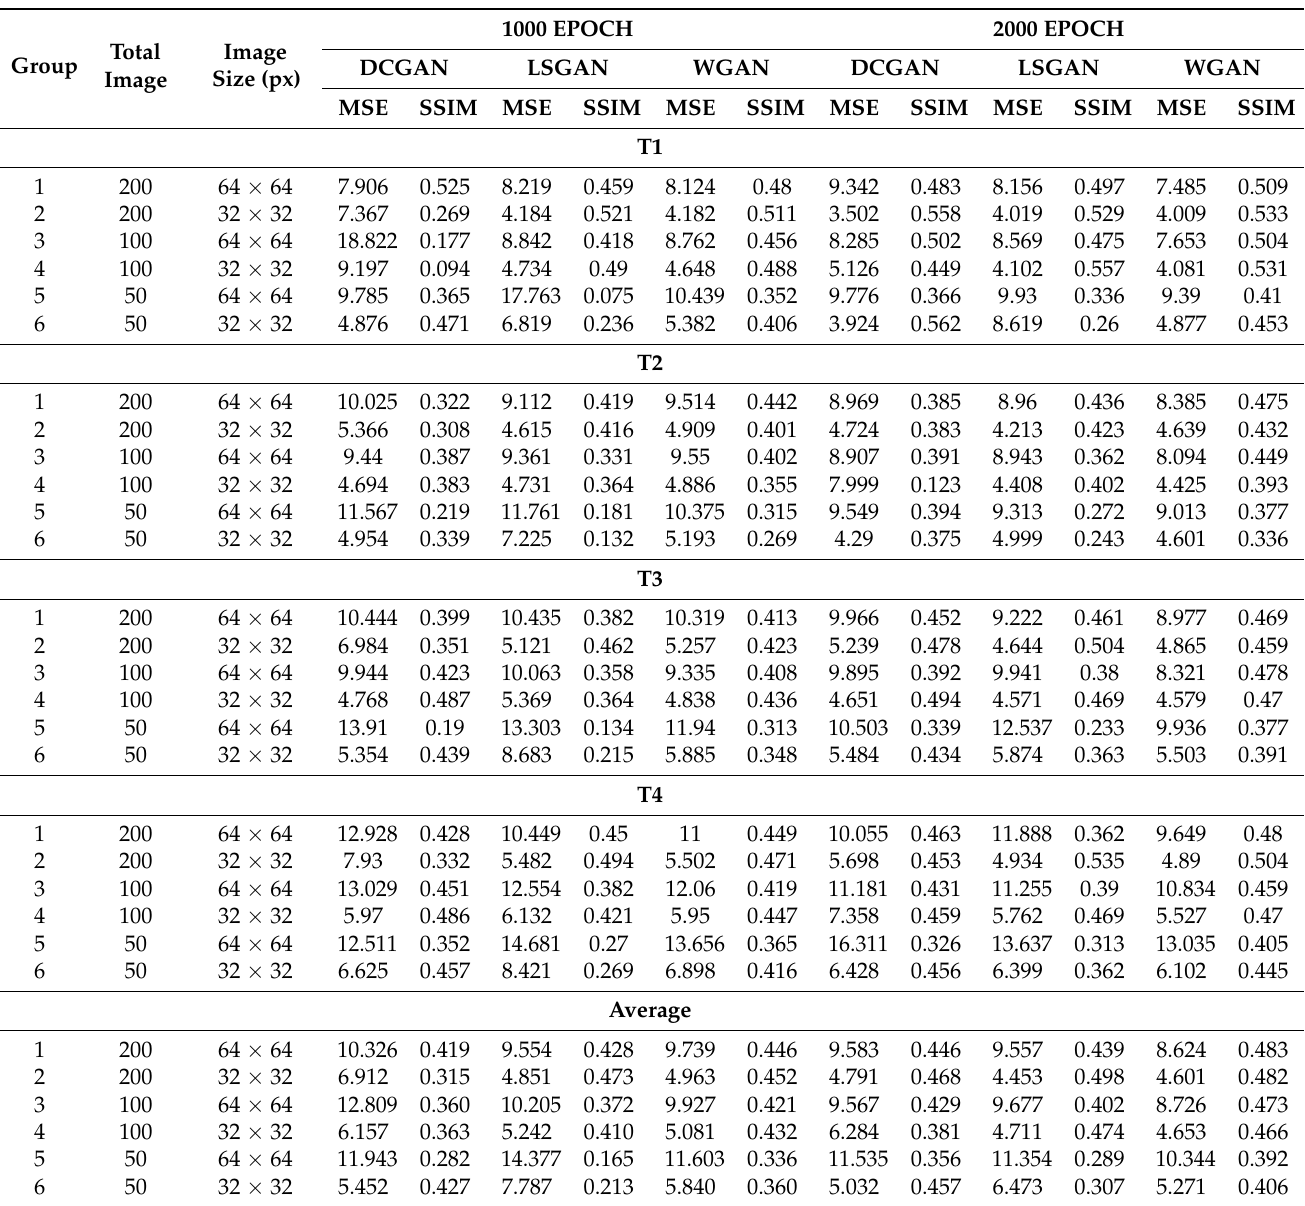
Table 4. Various GAN performance